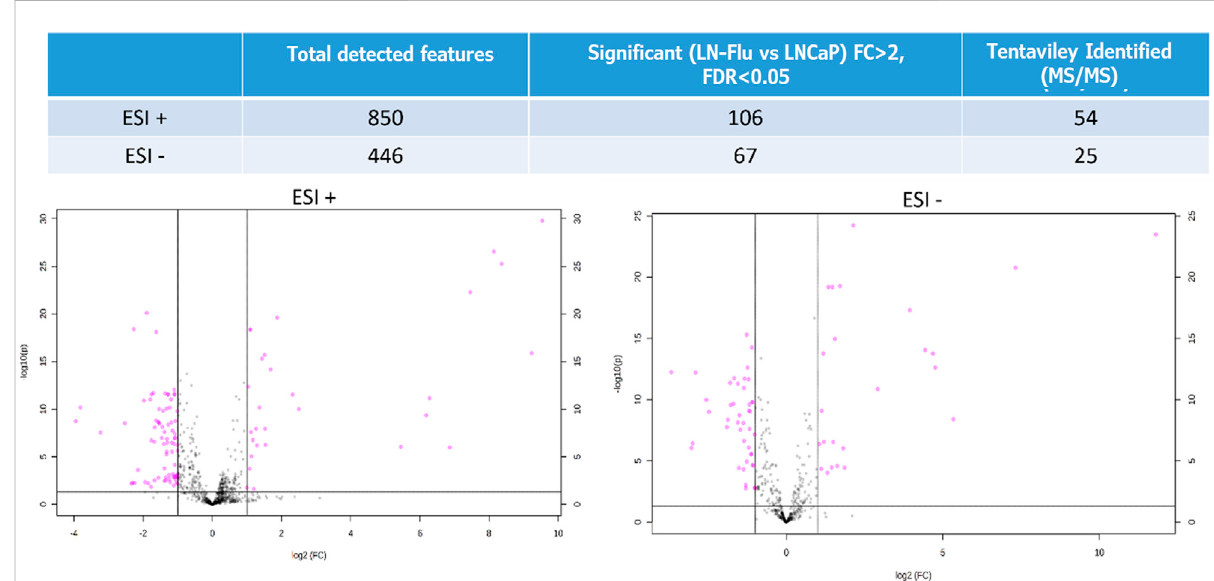
FIGURE 3 Volcano Plot showing the metabolomics statistically signi fi cant features in the LNFlu vs. LNCaP comparison, using both positive and negative MSionizationmethods.Blackdotsrepresentnonsigni fi cantfeaturesdetectedinthestudy,andpurpledotsrepresentsigni fi cantfeaturesintheLNFlu vs. LNCaP comparison (FDR < 0.05 and FC > 2 or FC <